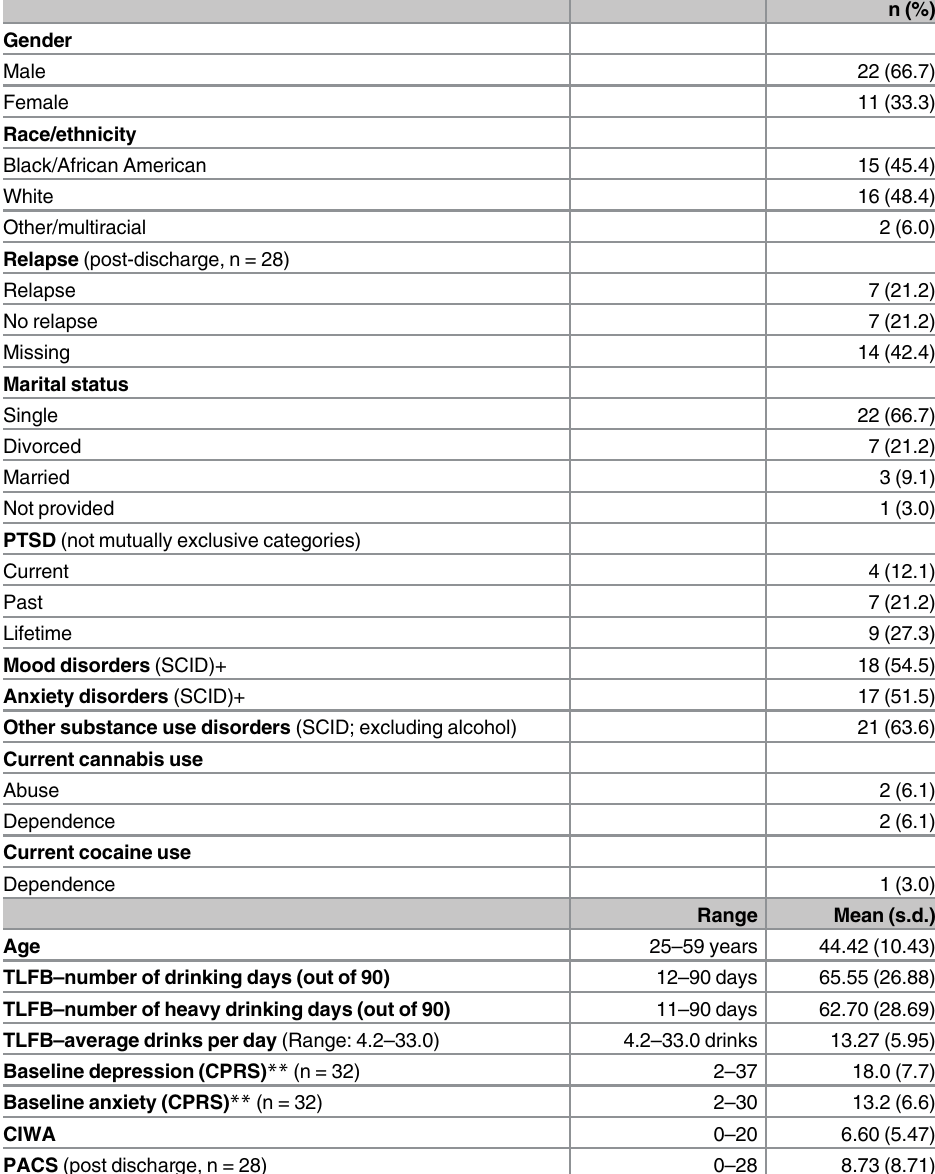
Table 1. Participant demographics and clinical variables (n = 33).